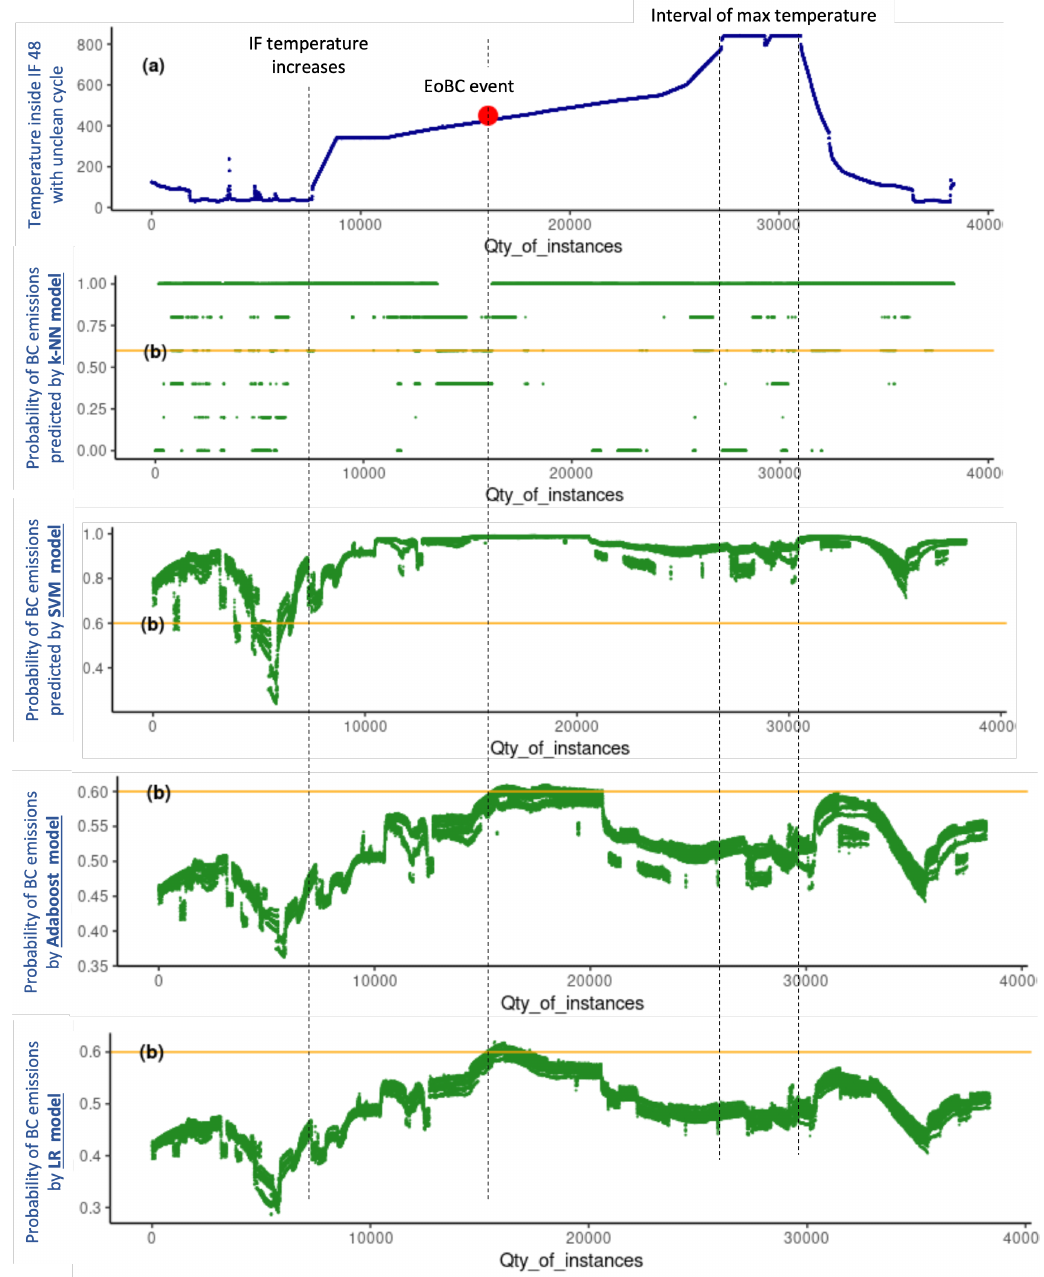
Figure 5. Probabilities of EoBC with unclean cycle of all models: k-NN, SVM, Adaboost and